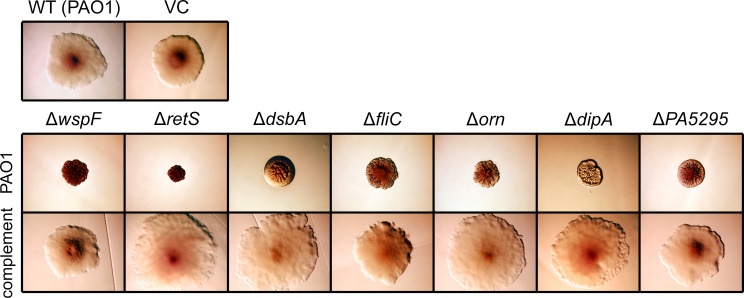
Multiple genes are linked to the RSCV phenotype.Precisely defined in-frame deletion mutations recreated the RSCV phenotype of transposon mutants. Mutations were complemented by expressing the deleted gene from its native promoter in trans. Here, this was done using a miniTn7 vector to insert a single copy of the deleted gene at the glmS site of the P. aeruginosa chromosome. Insertion of an empty miniTn7 vector into chromosome did not affect colony morphology. In all panels, bacteria were cultured and photographed on VBMM agar containing Congo red and brilliant blue R (see Material and Methods). Each panel represents an area that is approximately 5.0 mm × 3.5 mm. WT, wild type; VC, vector control.